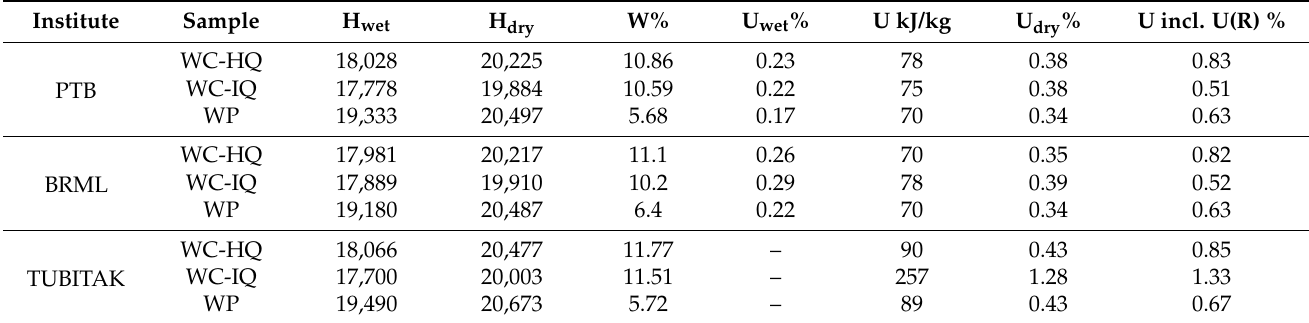
Table 4. Final expanded uncertainty (k = 2) of each institute in cycle